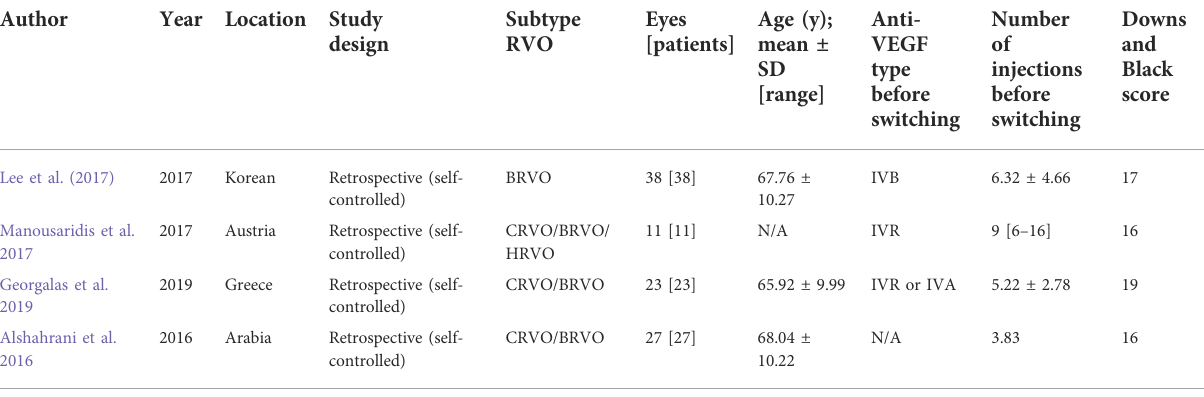
TABLE 1 General characteristics of four studies included in this